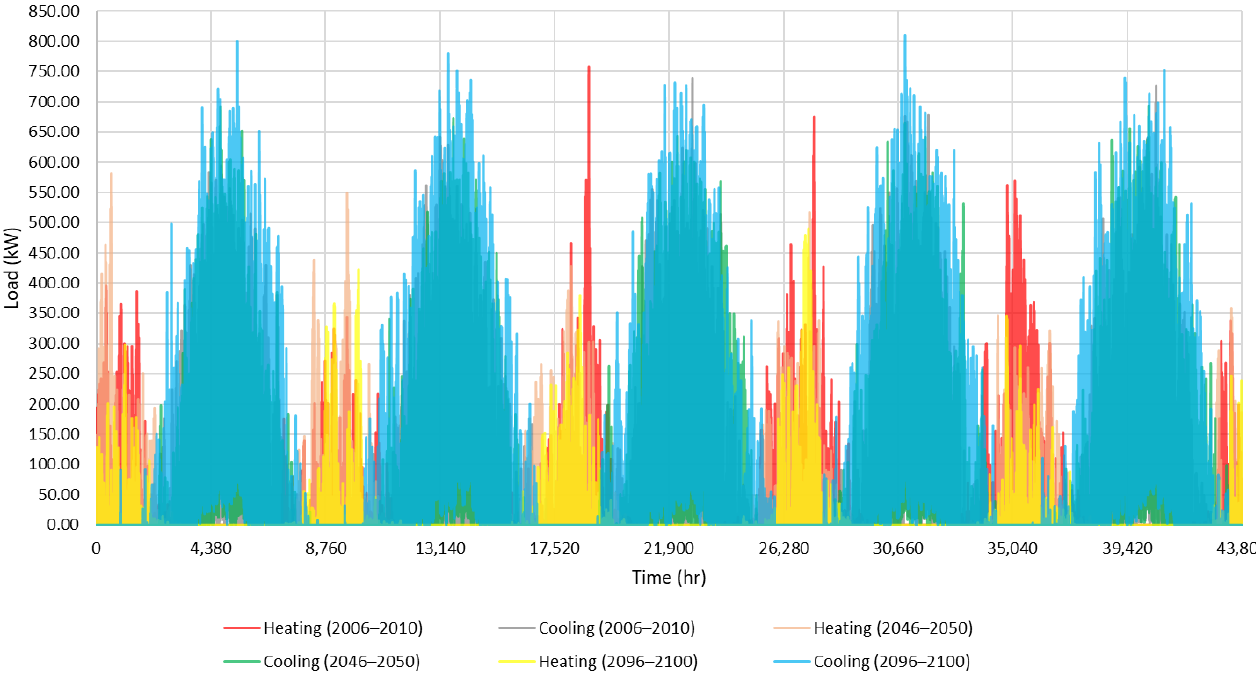
Figure 6. Hourly energy demand for HVAC purposes .